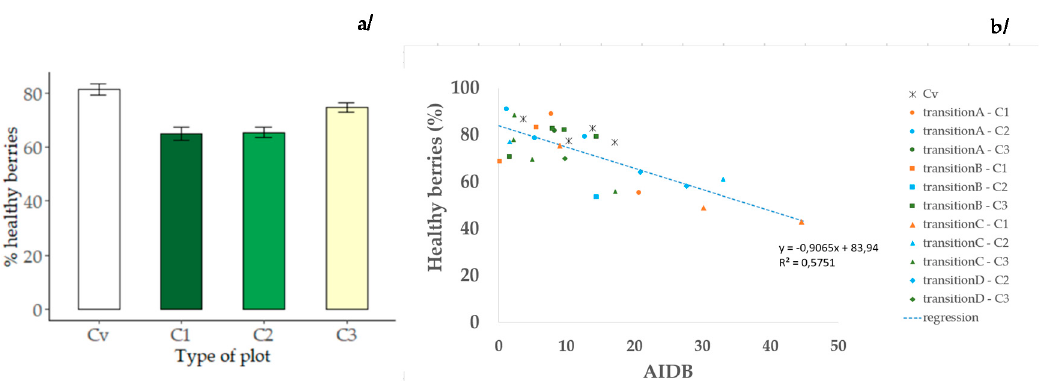
Figure 5. Percentage of healthy berries at harvest measured on conventional and in-conversion plots. ( a ) Dynamics of healthy berries percentage during conversion (error bars represent the standard errors); ( b ) Relationship among healthy berries percentages and AIDB (linear regression), the symbol shape indicates the intensity of the conversion process from A to D, the color shape indicates the stage of conversion (C1 to C3). We excluded two outliers from the analysis of this relationship which consisted of two plot * year situations with low percentages of healthy berries (21 and 37%) but null or quasi-null AIDB values. We identified them as 2015 occurrences of high severities of Black rot, not taken into account by AIDB.